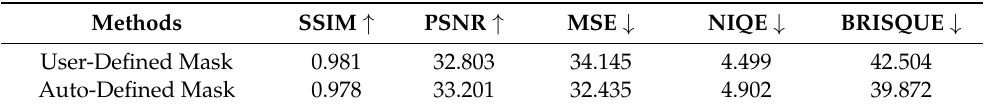
Table 3. Performance comparison between using user-defined mask and auto-defined mask in SSIM, PSNR, MSE, NIQE, and BRISQUE.